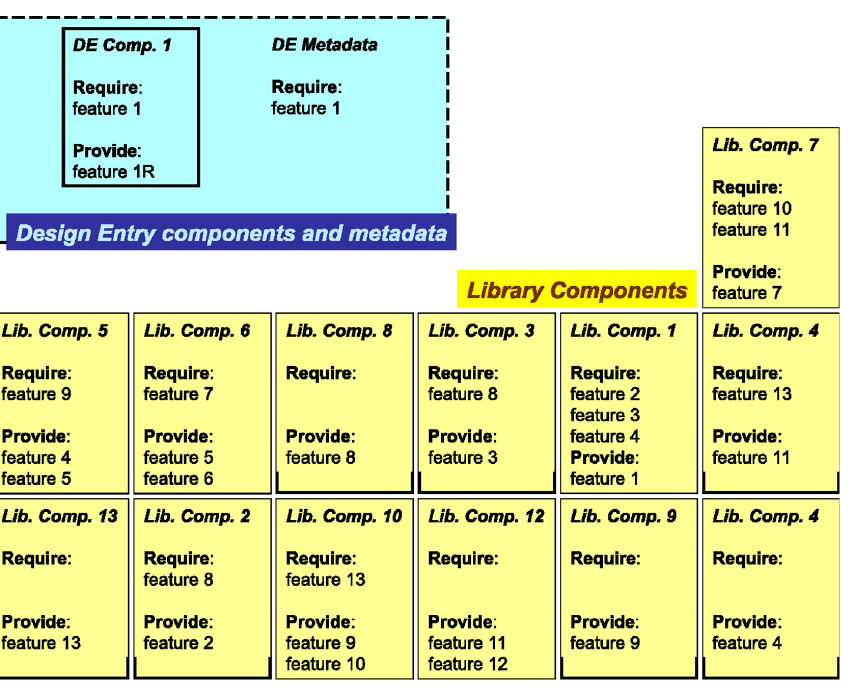
Figure 12. Simplified example of metadata and synthesis.